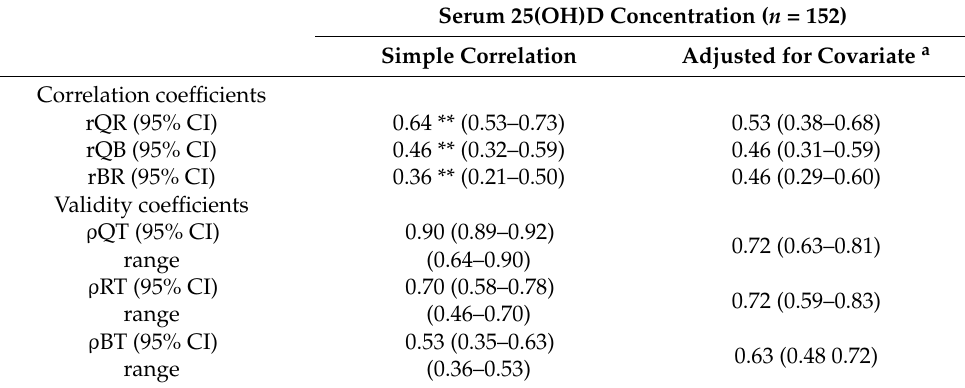
Table 8. Correlation coefficients between each of the three assessment methods and the validity coefficient calculated with the method of triads, Simple and adjusted for covariates a . Serum 25(OH)D Concentration ( n = 152)